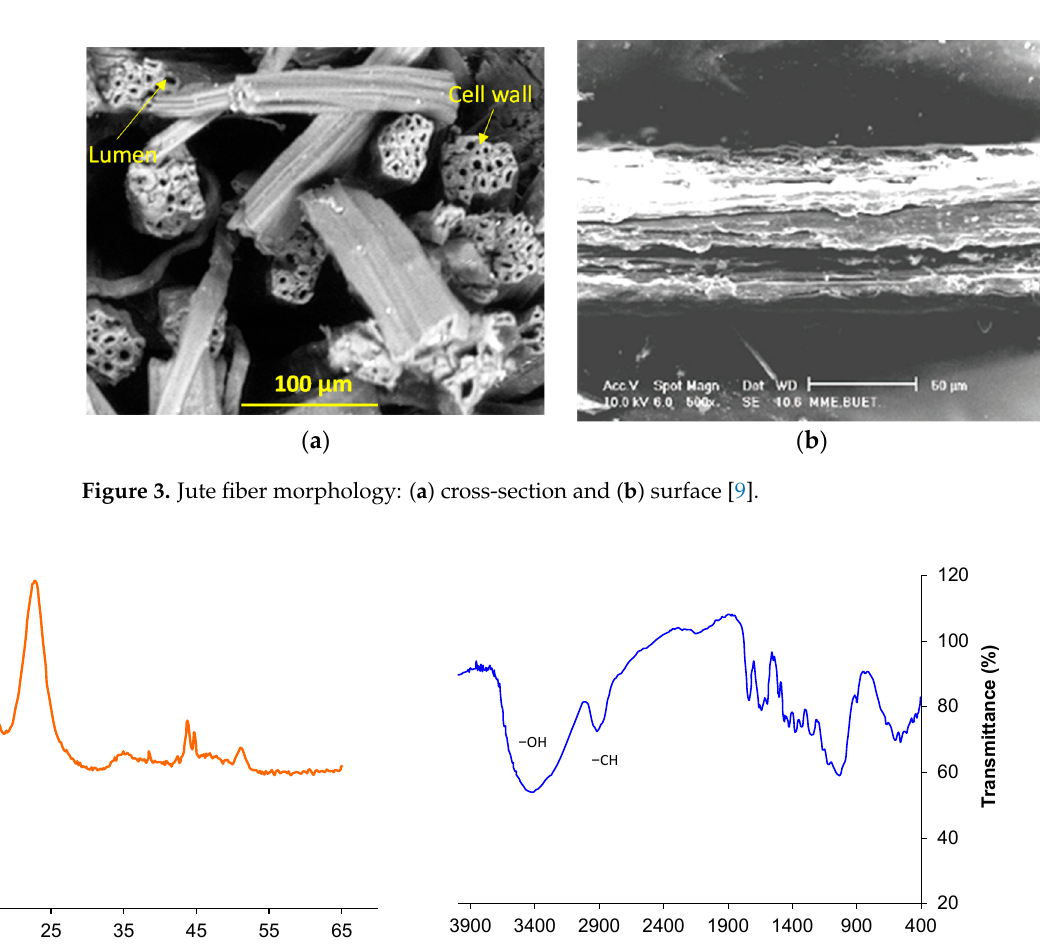
Figure 3. Jute fiber morphology: ( a ) cross-section and ( b ) surface [9].